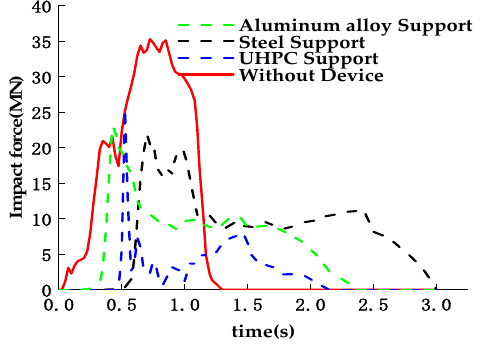
Figure 18. Impact force time-history curve of the pier.